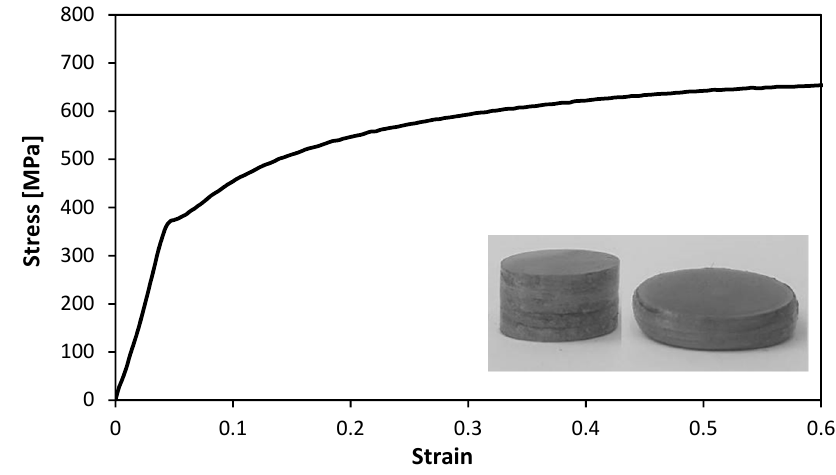
Figure 3. Stress-strain curve of the high-strength low alloy (HSLA) 340 steel obtained from stack compression tests.